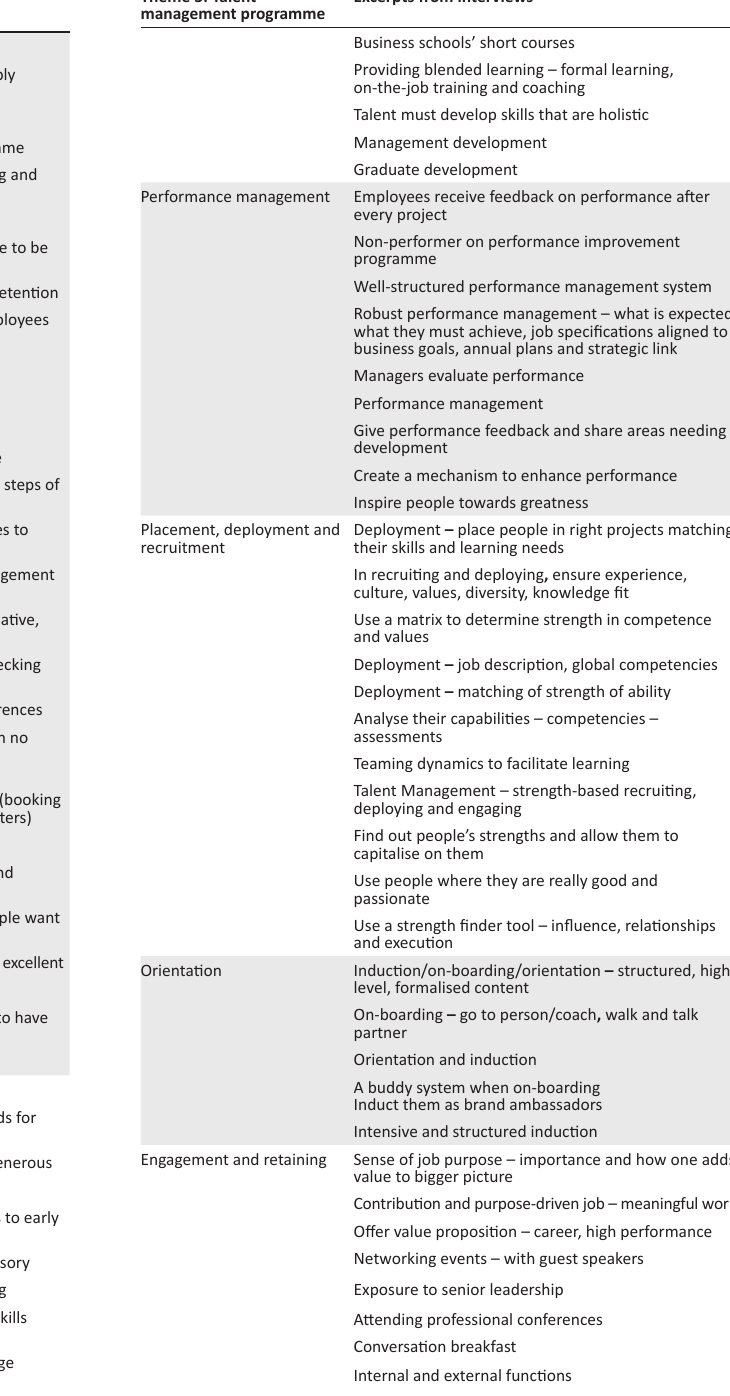
TABLE 3: Talent management programme